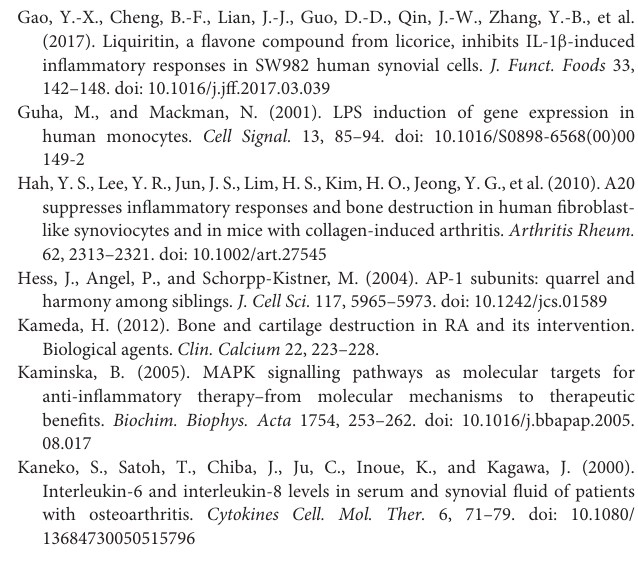
FIGURE S1 | Summary of anti-inflammatory mechanisms of